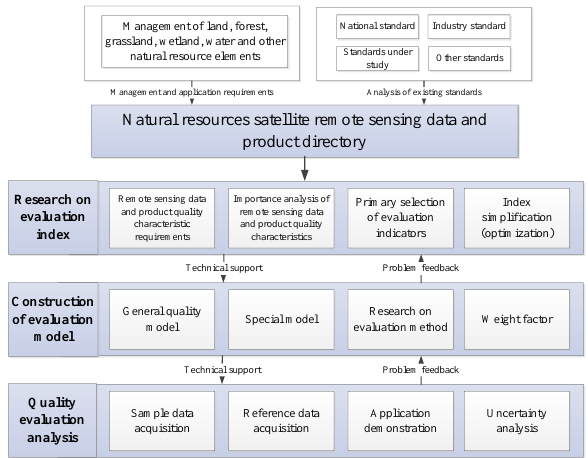
Figure 1 . Overall framework of quality evaluation